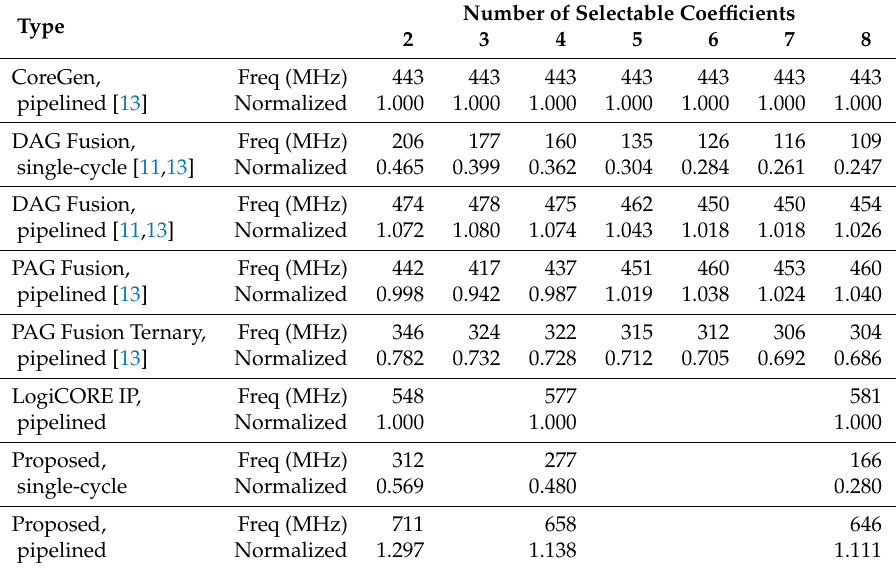
Table 14. Maximum operating frequency for DAG fusion [11,13], PAG fusion [13] and proposed (16 × 16)-bit KCMs with two to eight selectable coefficients. DAG fusion and PAG fusion units are normalized to CoreGen as presented in Möller et al. [13], proposed units are normalized to a LogiCORE IP multiplier-based